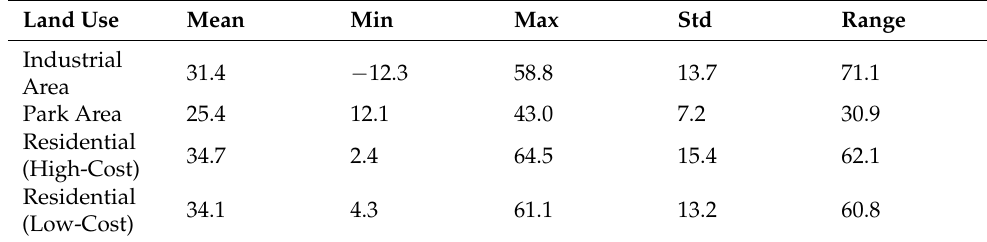
Table 7. Statistics (LST, ◦ C) of each LU for eight flights.